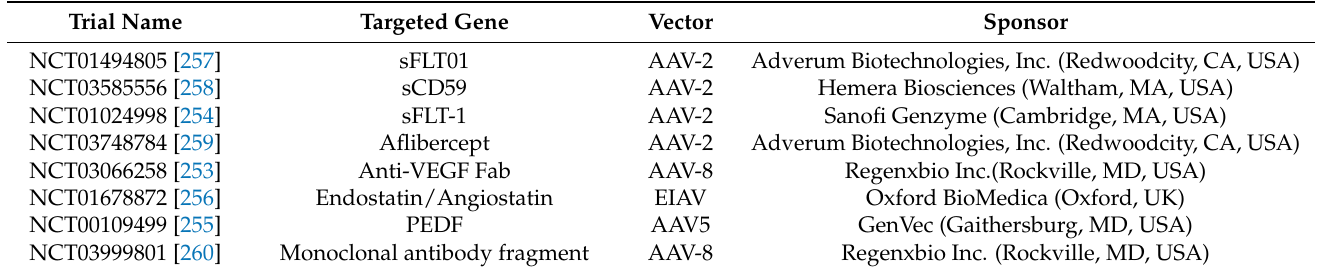
Table 6. Ongoing gene therapy clinical trials for